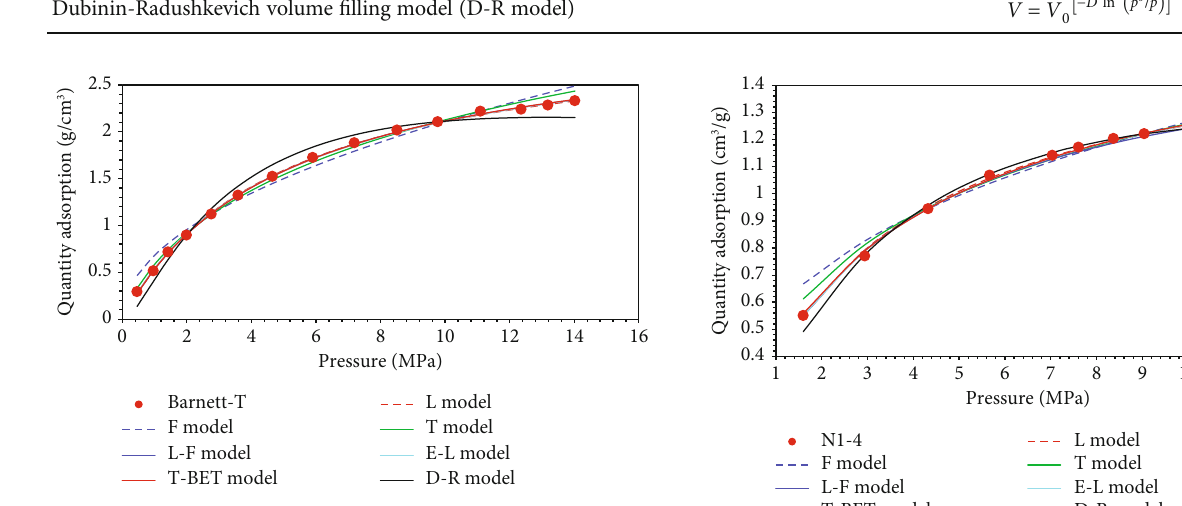
Figure 5: Fitting curves of di ff erent adsorption models for the Barnett shale reservoir sample [22].